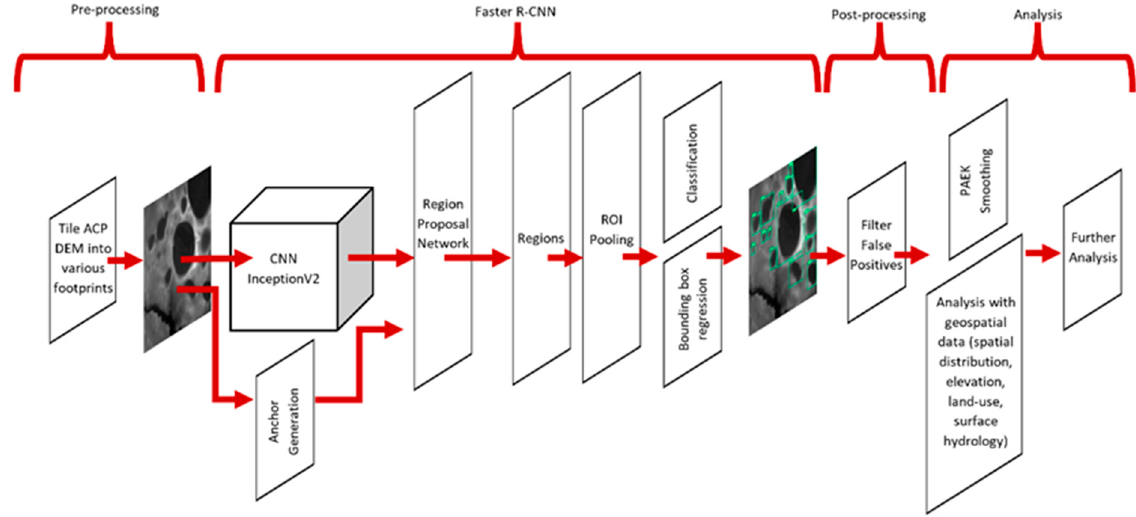
Figure 7. The general workflow for getting from the ACP DEM to Carolina Bay detections with information on spatial distribution, morphology, land-use and land-cover, and surface hydrology.